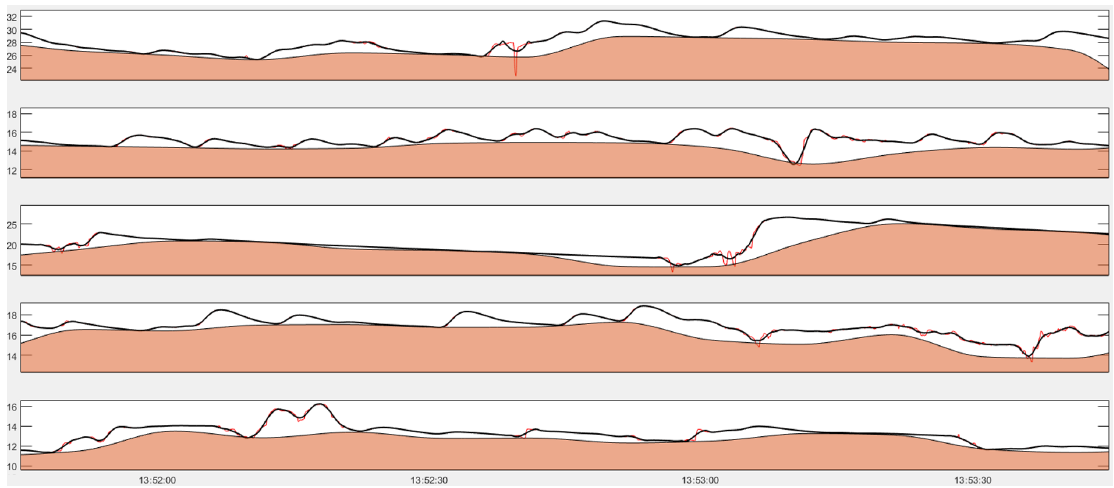
Figure 7. An example of EDA (in µ S) of five participants in the same class. A red trace represents an original signal, a black trace represents the signal after applying S-G filter, and red shade represents the tonic level computed by